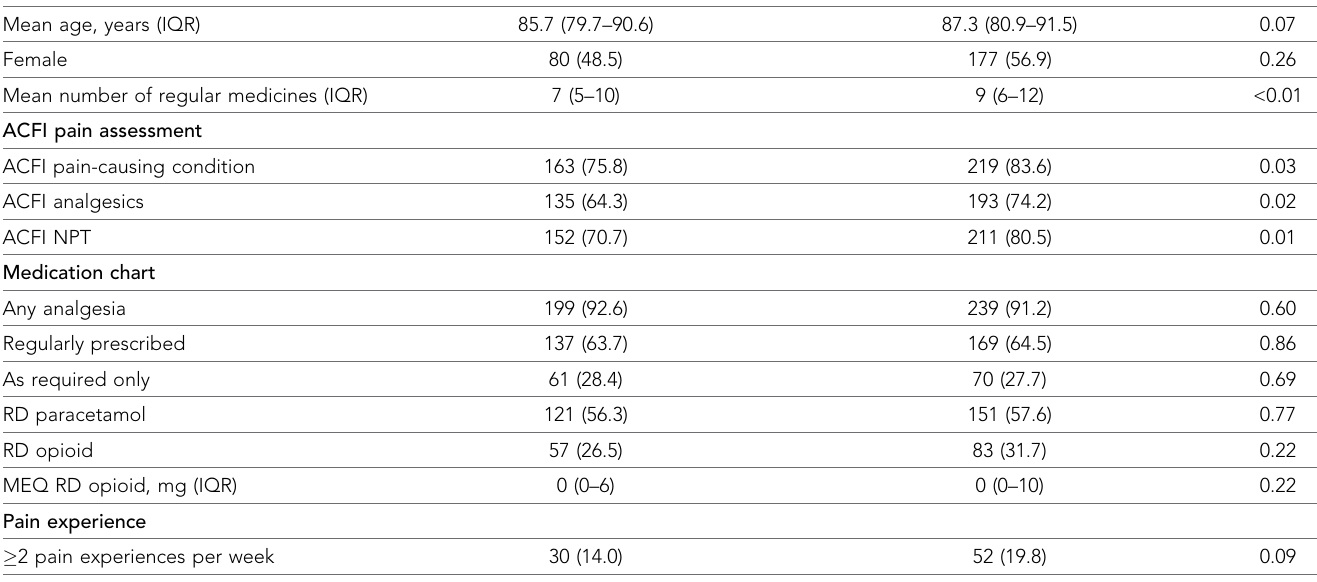
Table 3. Baseline demographics and patient characteristics of those with and without